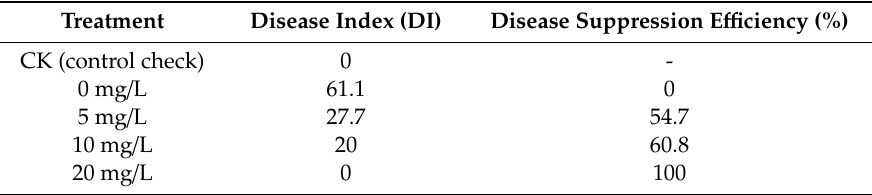
Table 4. Disease index and disease suppression e ffi ciency of rice bacterial blight.